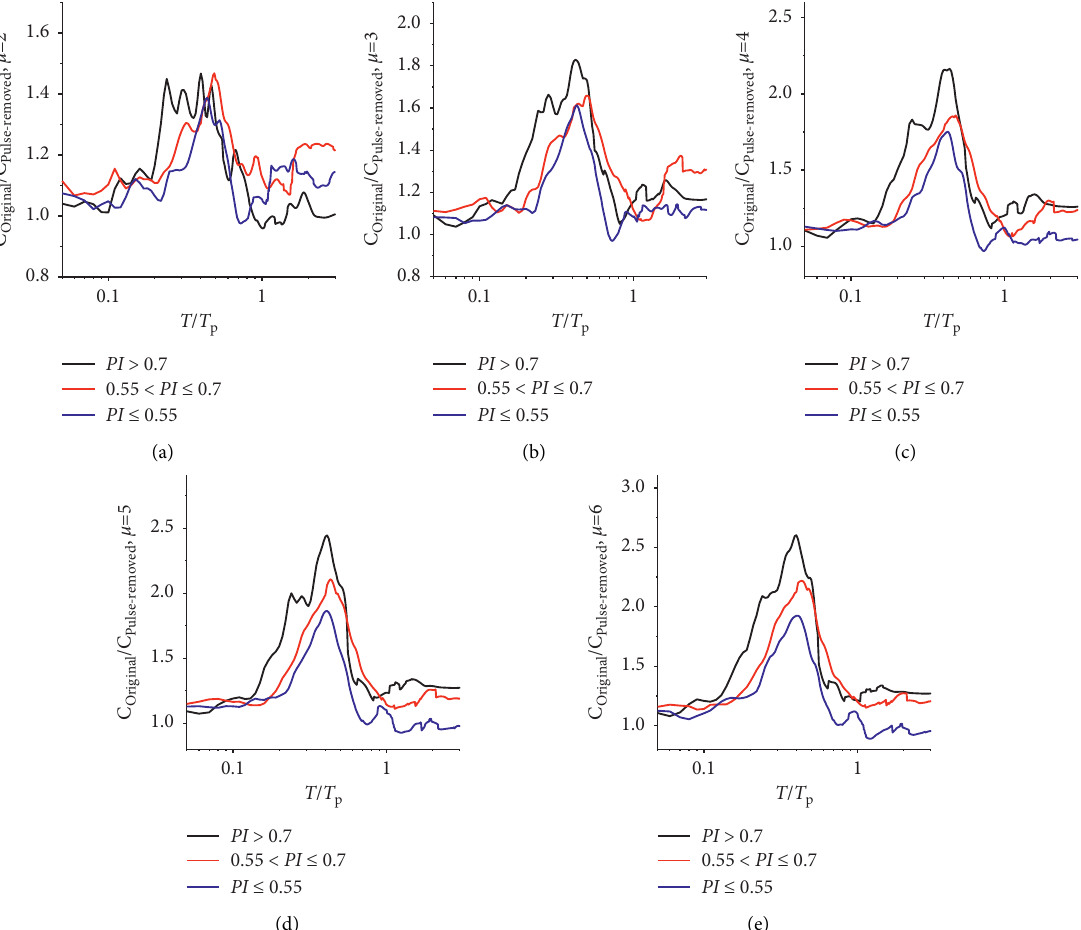
Figure 8: Comparison of the ratios for the inelastic displacement ratios between the original ground motions and the pulse-removed parts for (a) µ � 2, (b) µ � 3, (c) µ � 4, (d) µ � 5, and (e) µ � 6.